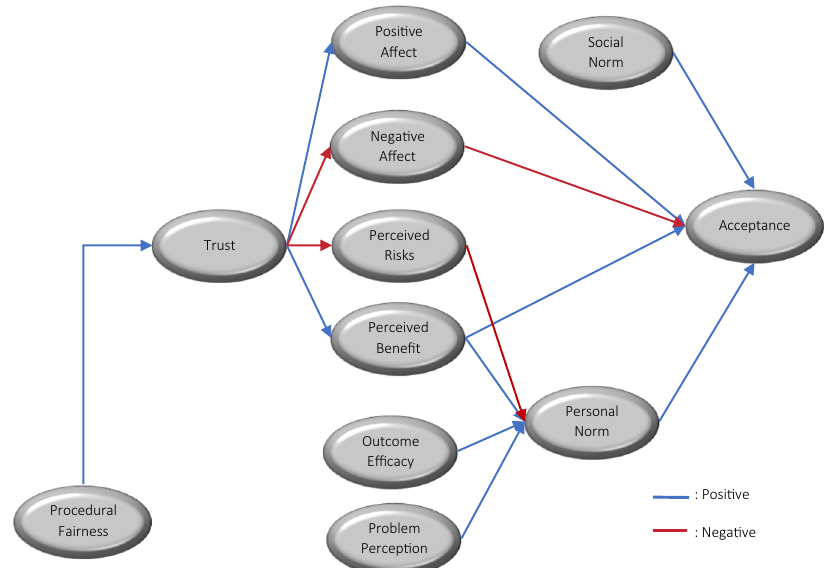
Fig. 4 Structural model results for the social acceptance of Quarries in Milan, Italy. Insigni fi cant variables are dropped from the theoretical model. Arrows represent the direction of causality between the latent variables. The red and blue arrows represent negative and positive associations,